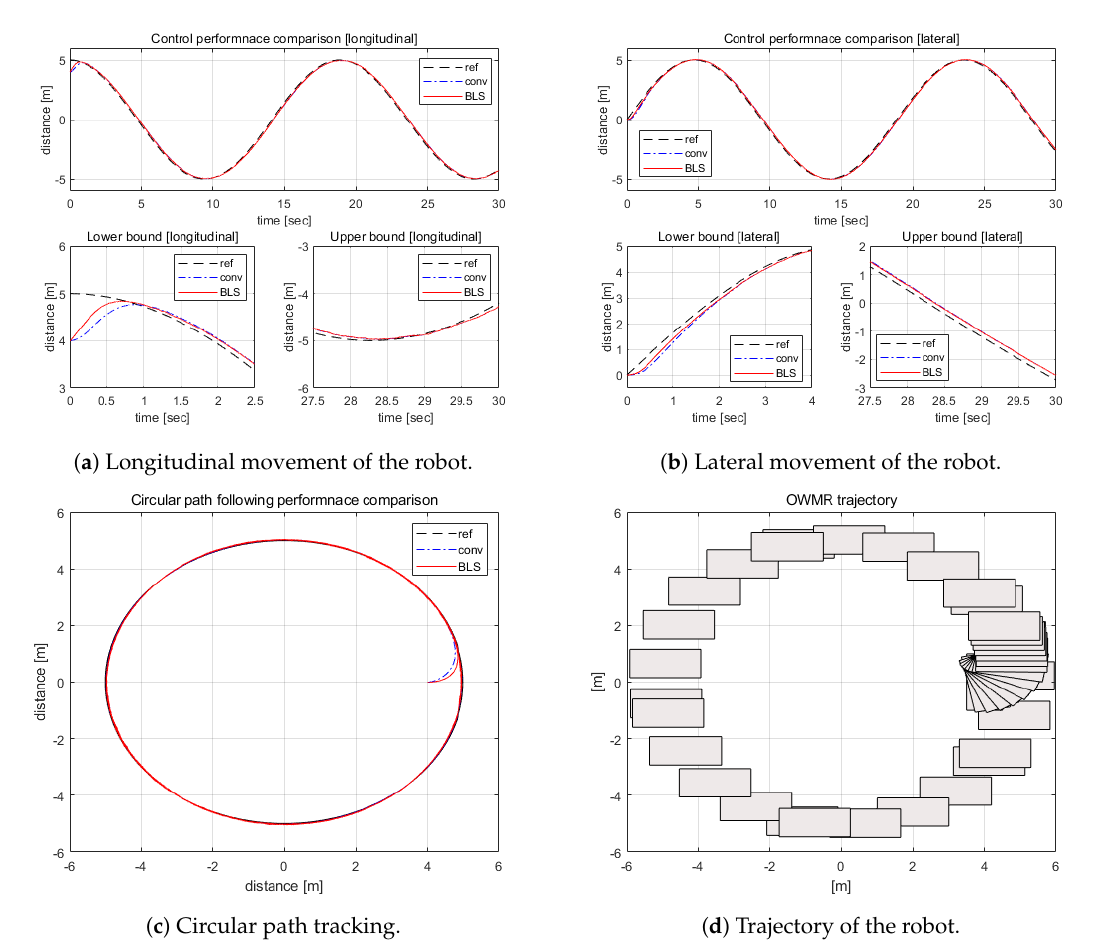
Figure 9. Circular movement of the